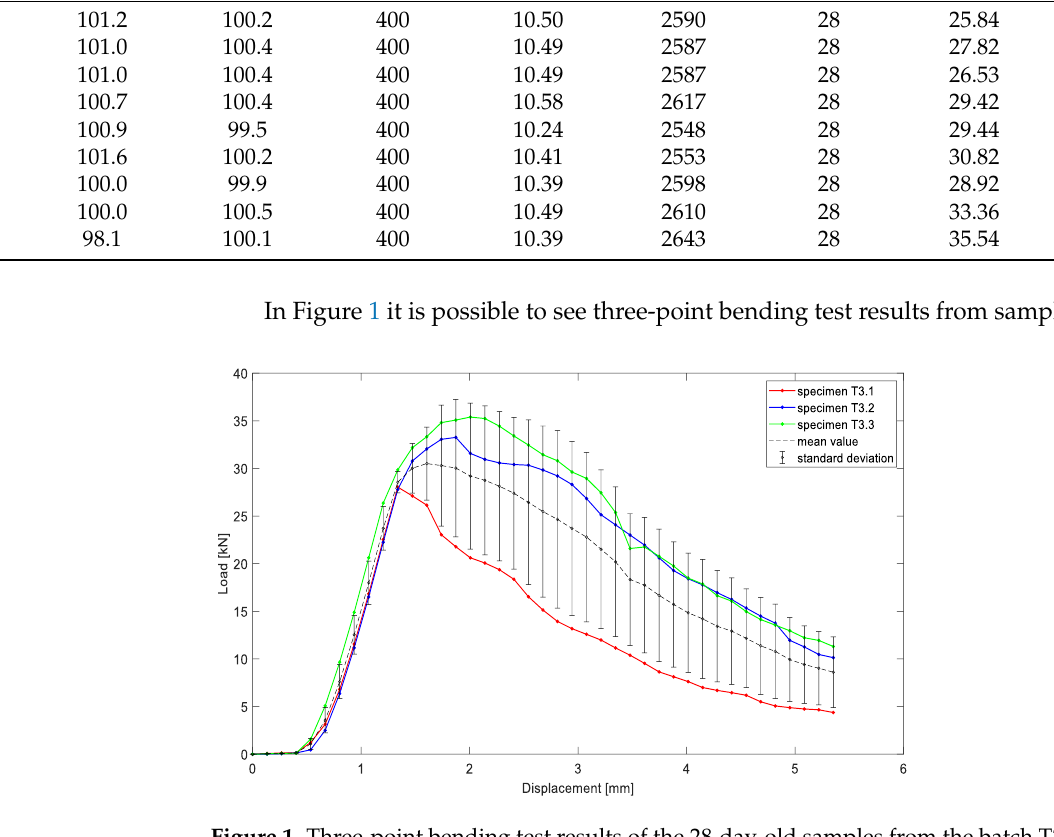
Figure 1. Three-point bending test results of the 28-day-old samples from the batch T3.1 – T3.3.